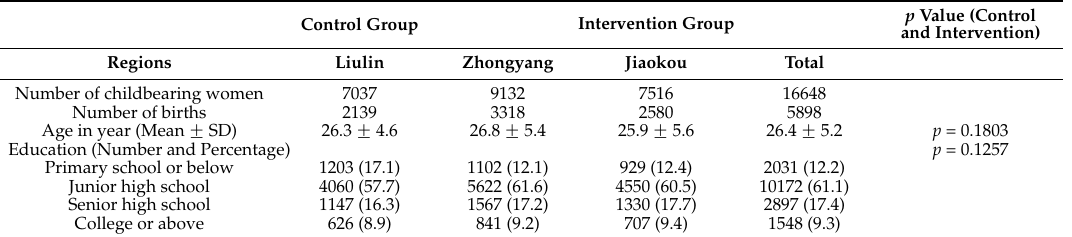
Table 1. Demographic characteristics of the intervention group and the control group.